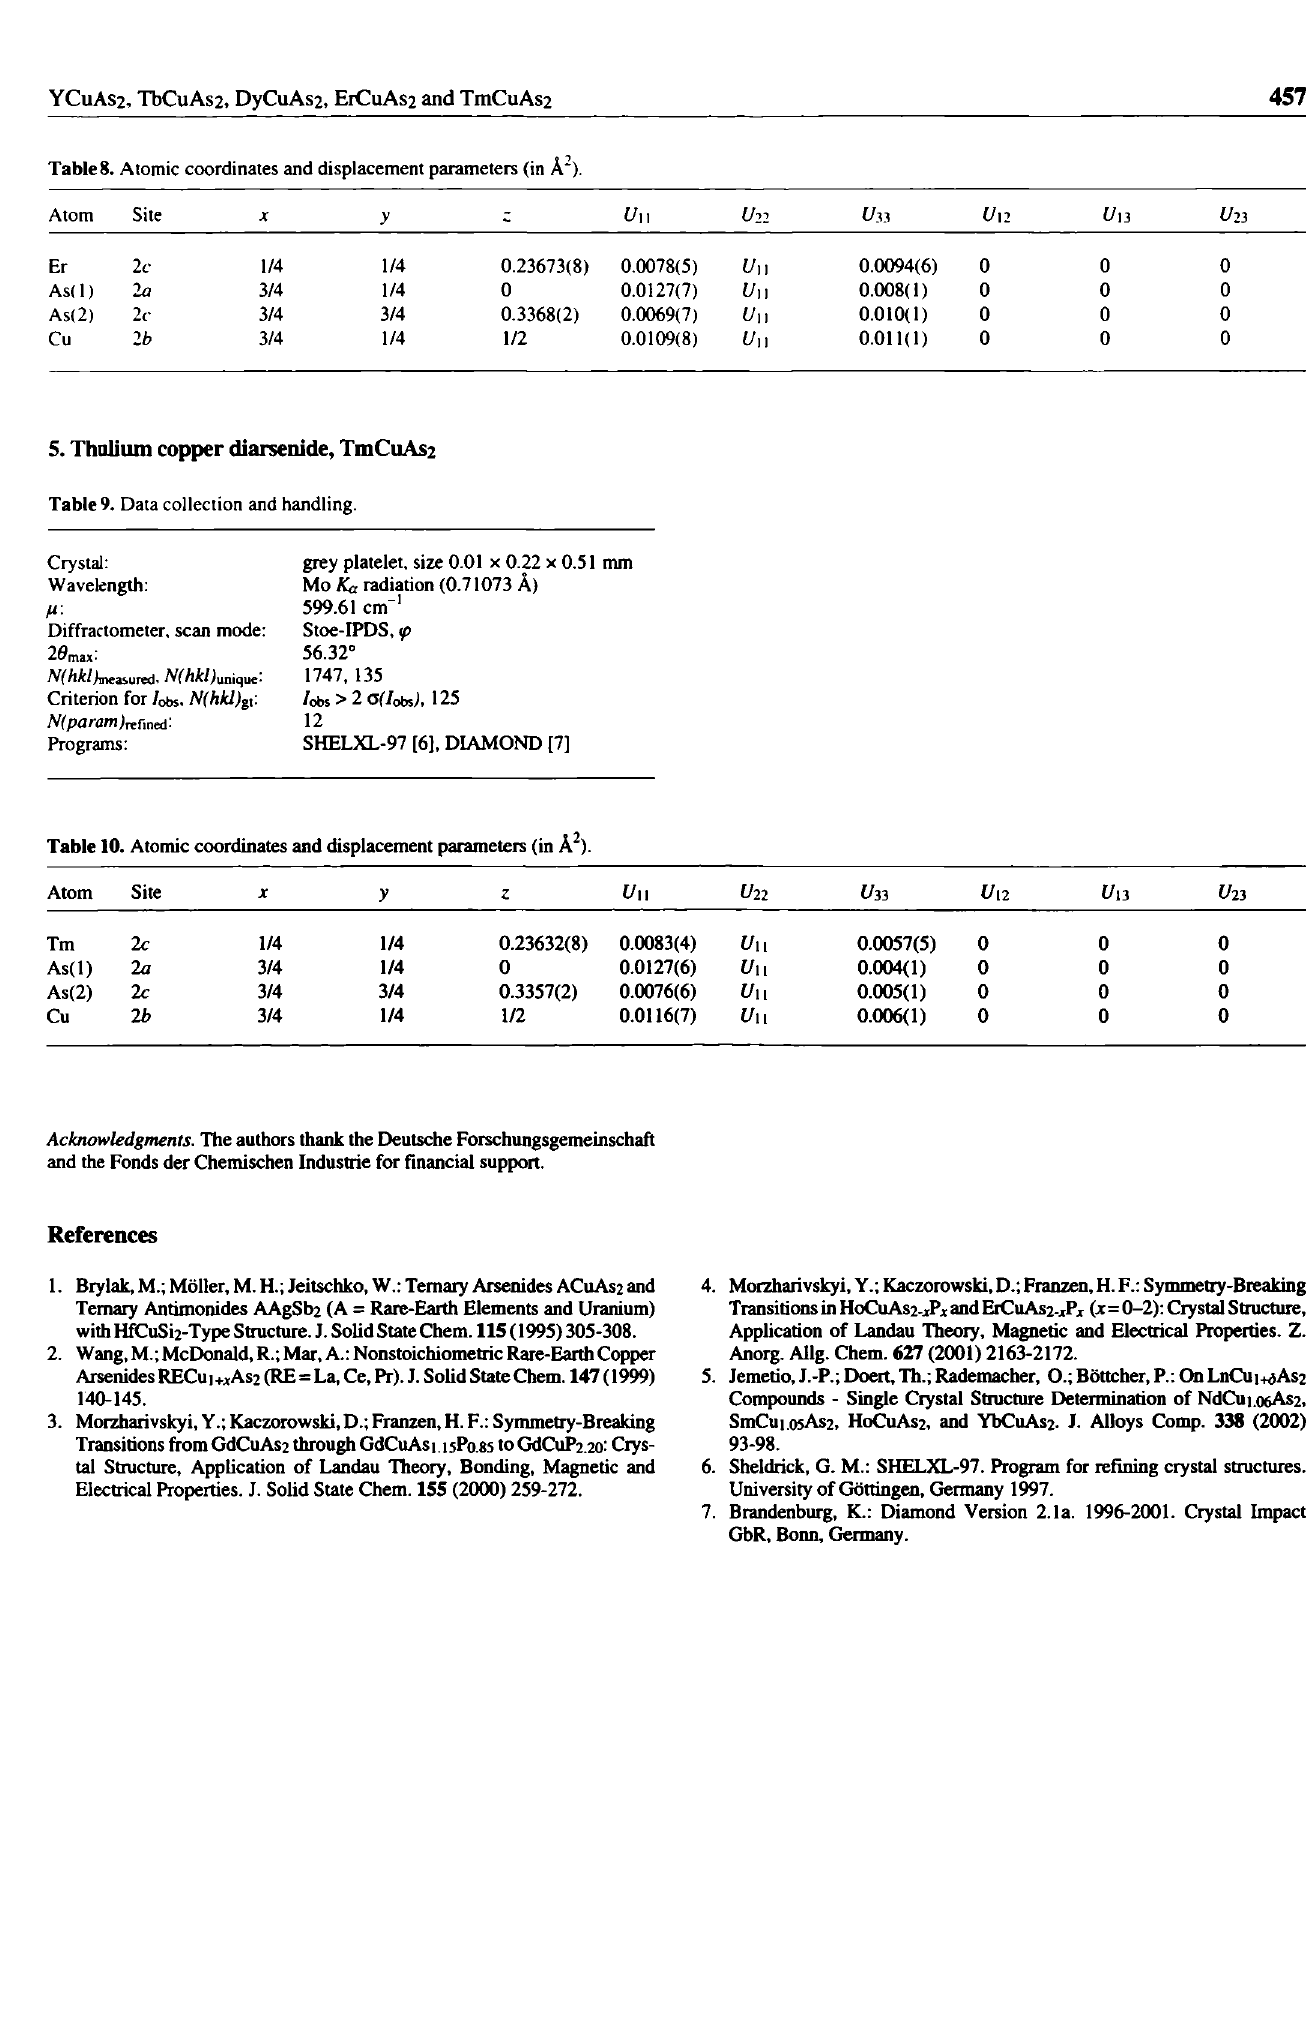
Table 9. Data collection and handling.